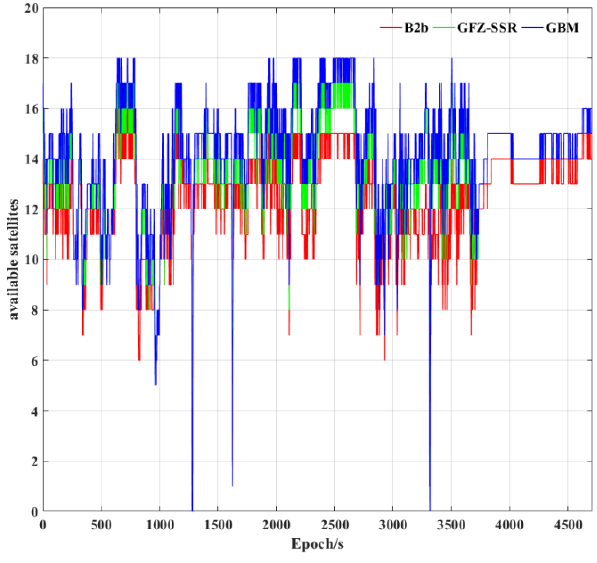
Figure 6. The available satellites for BDS − 3 and GPS during the experiment. Table 3. Average number of available satellites.